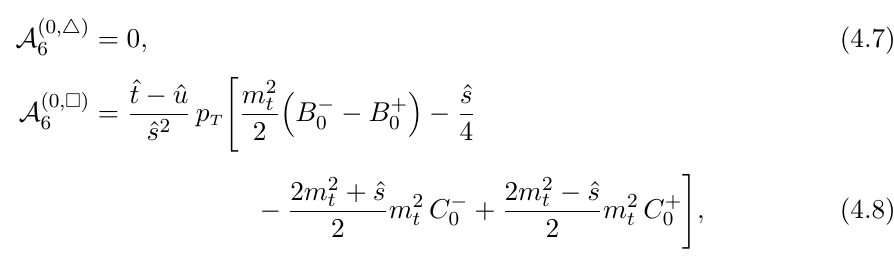
-expansion (dashed lines). In the T -expanded one at various orders is T